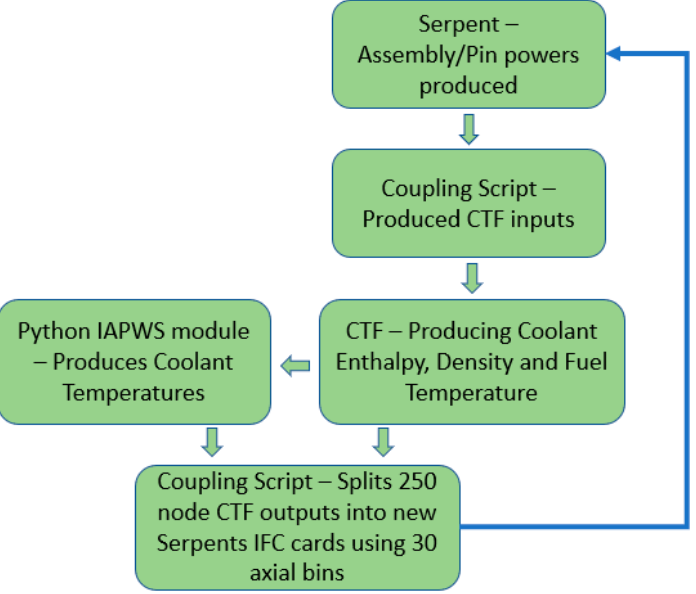
Figure 4. The code coupling procedure between Serpent and Cobra-TF (CTF).